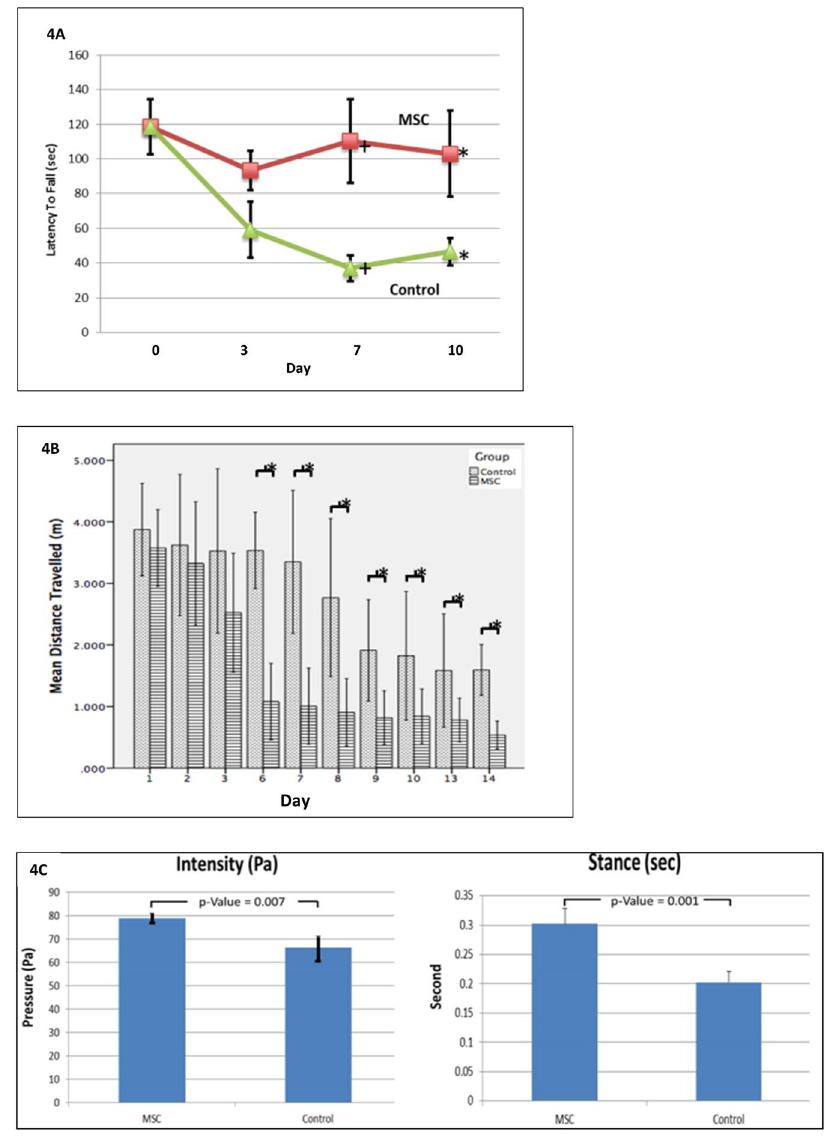
Figure 4. Behavioral assessment of rats with and without MSC treatment following TBI. Rats treated with topical MSCs showed a significant improvement in behavioral assessment. Parameters were expressed in mean + standard deviation. Topical MSCs improved the coordination and integration of movement motor function in the Motor Rod Test ( 4A ). The animals travelled a shorter distance to reach the platform in the Water Maze Test ( 4B ). Automated gait analysis illustrated the greater intensity (mean pressure exerted on the floor by one individual paw) and longer stance (duration during which the paw is in contact with the glass plate) by the MSC-treatment group ( 4C